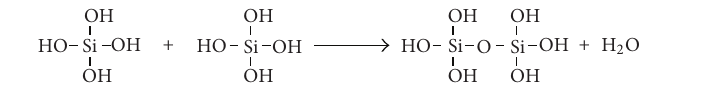
F 1: Condensation of two orthosilicate molecules with the elimination of water. is process can be continued ad in�nitum to lead to long insoluble biosilica molecules.